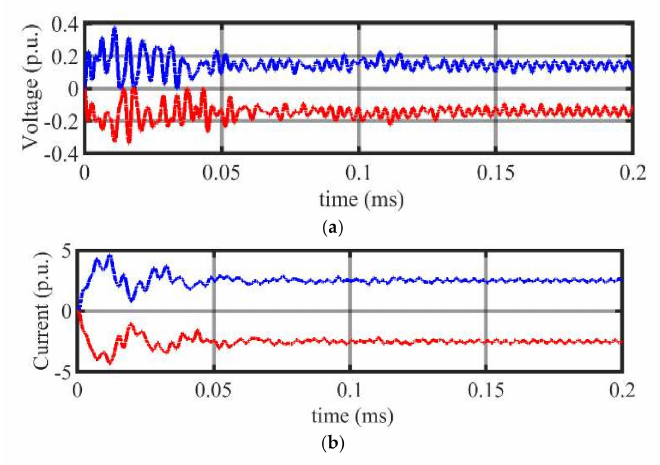
Figure 19. ( a ) DC voltage and ( b ) DC current profiles at RS-I during PP fault.